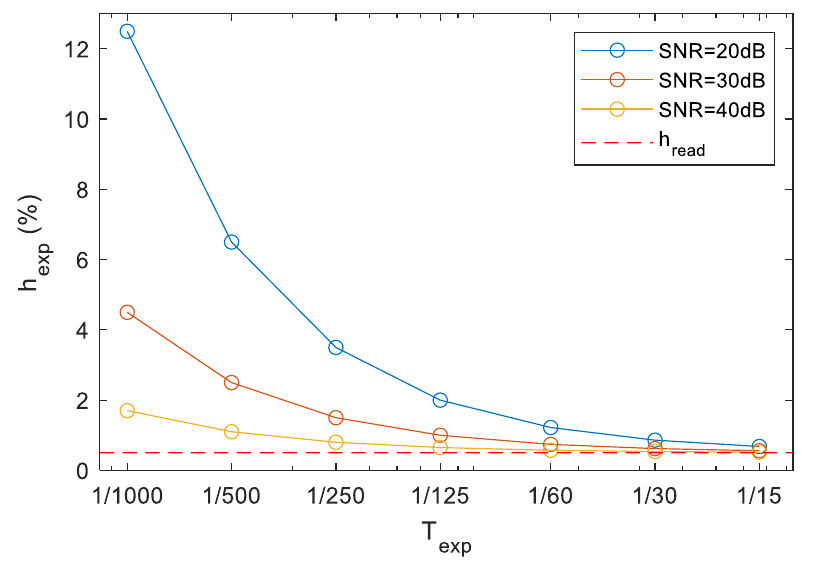
Figure 6. Relative measurement uncertainty of the direct method. Table 2. Measurement results of C1, with the direct